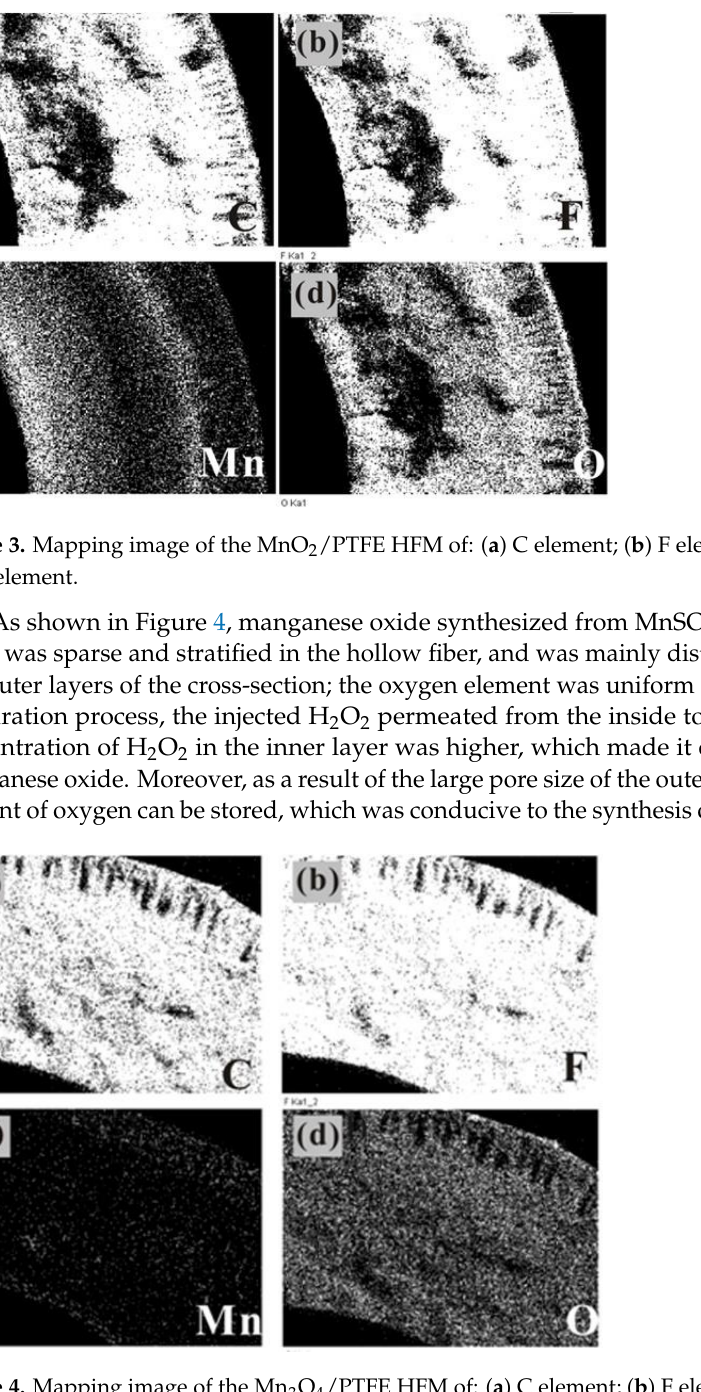
Figure 4. Mapping image of the Mn 3 O 4 /PTFE HFM of: ( a ) C element; ( b ) F element; ( c ) Mn element; ( d ) O element.